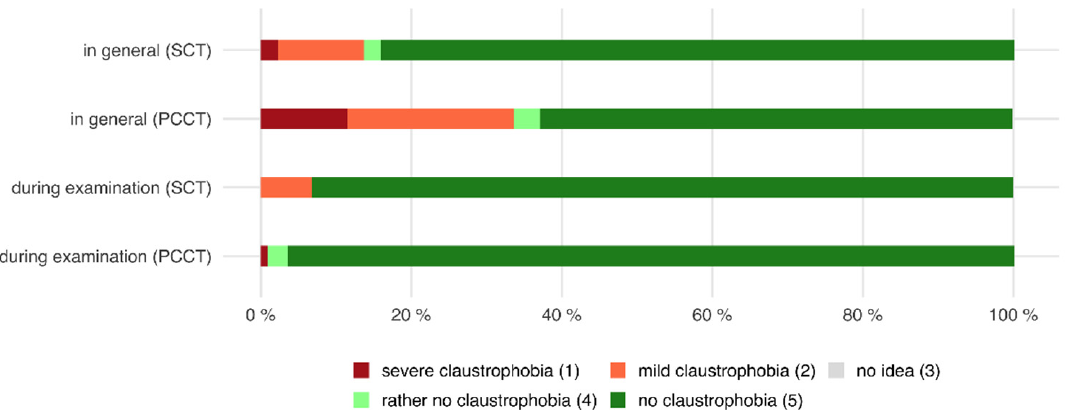
Figure 1. Horizontal stacked bar chart showing the distribution of answers regarding the perceived feeling of claustrophobia in general and during the CT examination. Although the percentage of patients declaring that they generally have claustrophobia before the CT examination is considerably high (33.6% PCCT; 13.6% SCT), only a few patients stated that they felt claustrophobic during the examination (PCCT 4.94 ± 0.4 versus SCT 4.80 ± 0.8, p = 0.369).